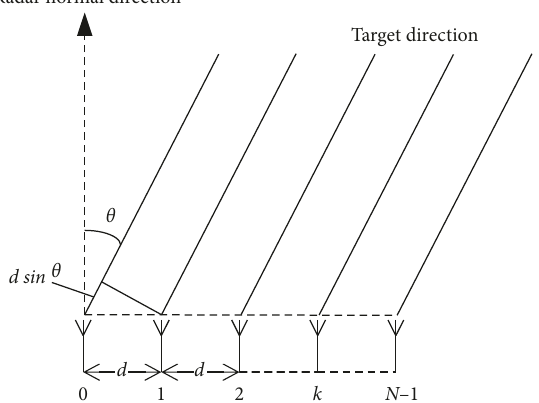
Figure 1: Angle measuring diagram of antenna array.